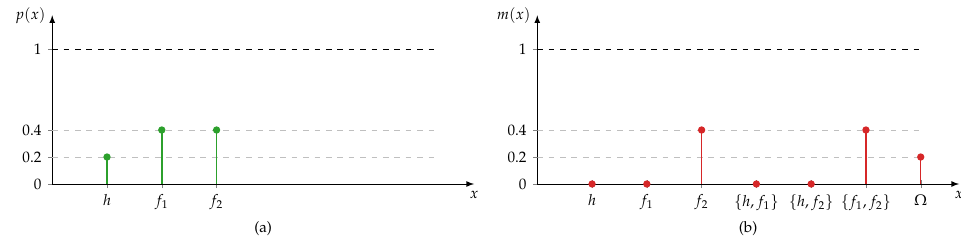
Figure 5. Probability theory versus Dempster-Shafer’s theory in a condition monitoring example. The basic propositions are h : the monitored object is healthy and f 1 , f 2 : the object is in one of two fault states. The distribution modelled with ProbT ( a ) is ambiguous since it cannot distinguish between ignorance (epistemic uncertainty) and well-informed uncertainty (aleatoric uncertainty). Using DST ( b ), it turns out that the expert or model is indeed partly ignorant. This is expressed ) = 0.4 (a fault occurred but it is unknown which one) and by m ( Ω ) = 0.2 by m ( f 1 , f 2 { }